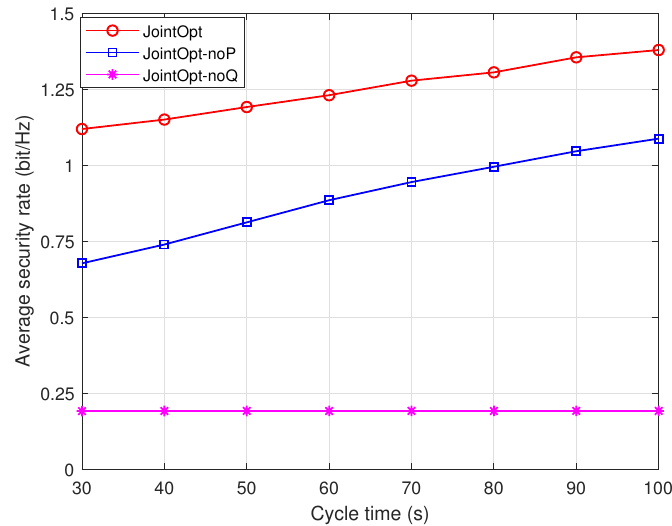
Figure 7. System security rate performance